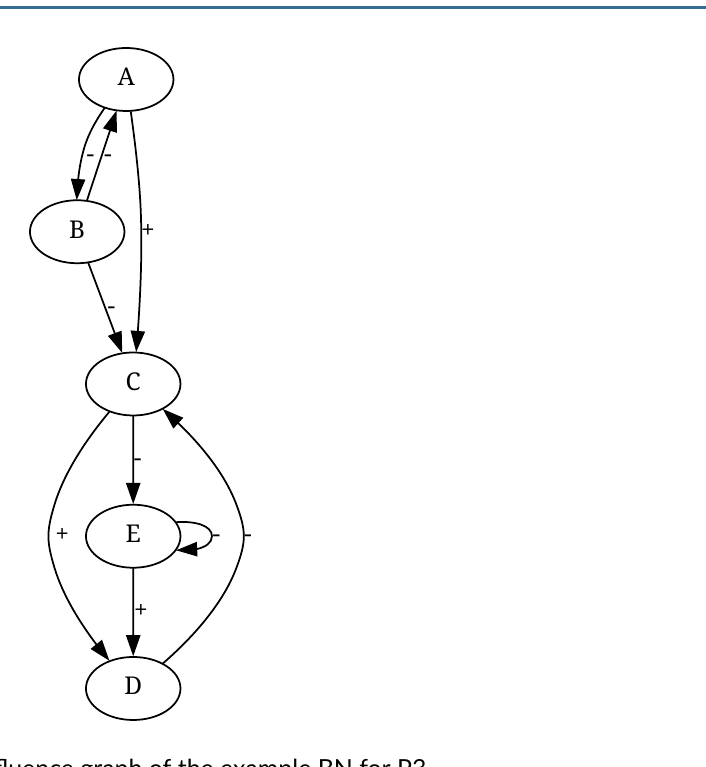
Figure 5 – Influence graph of the example BN for